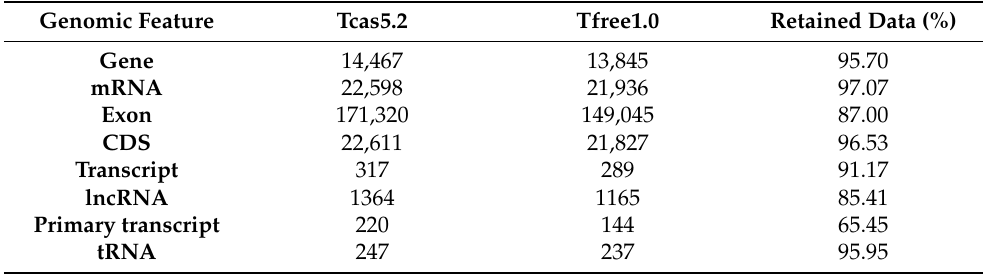
6 of 19 Figure 3. Gene completeness assessment using BUSCO analysis of T. freemani Tfree1.0 and T. casta- neum Tcas5.2 assembly on all linkage groups and unplaced contigs in both species. Comparison of complete and single-copy, complete and duplicated, fragmented and missing BUSCO genes ex- pressed in percentages ( left ) and absolute gene numbers ( right ).